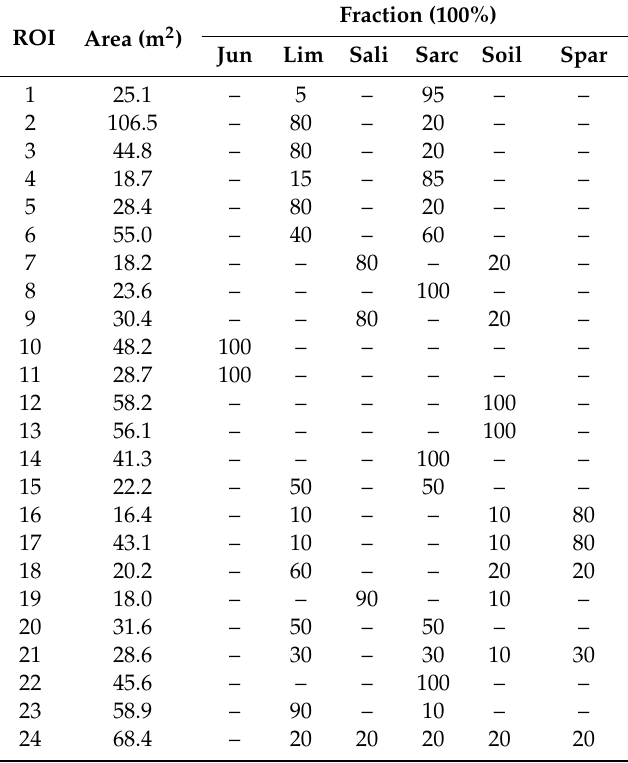
Table 2. Field measurements of fractional abundance of each class in the San Felice salt marsh (Venice, Italy). Jun = Juncus , Lim = Limonium , Sali = Salicornia , Sarc = Sarcocornia and Spar = Spartina.